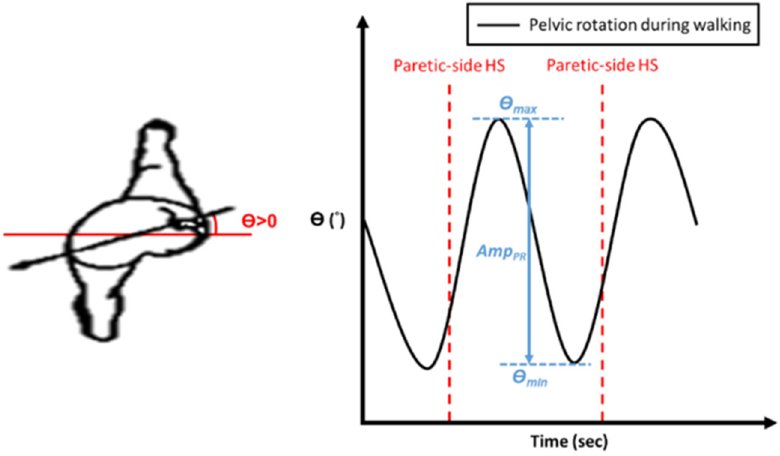
Figure 6. Definition of the amplitude of pelvic rotation Amp PR . Table 5. The amplitude of pelvic rotation ( Amp PR ) using the original